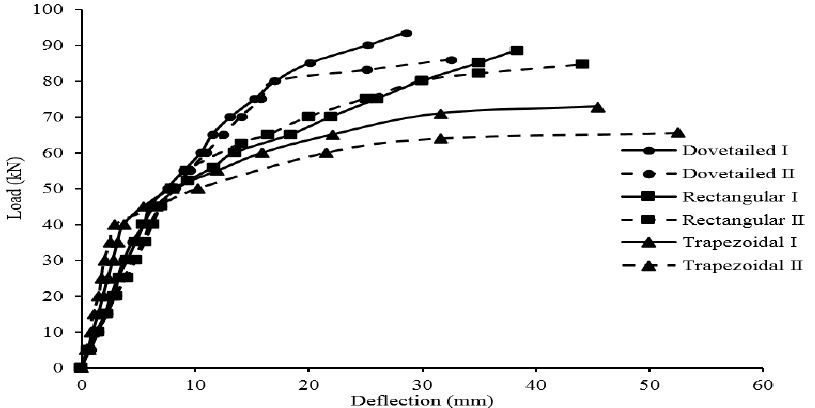
Figure 10. Load versus deflection curve of profiled composite slabs for trials I and II.